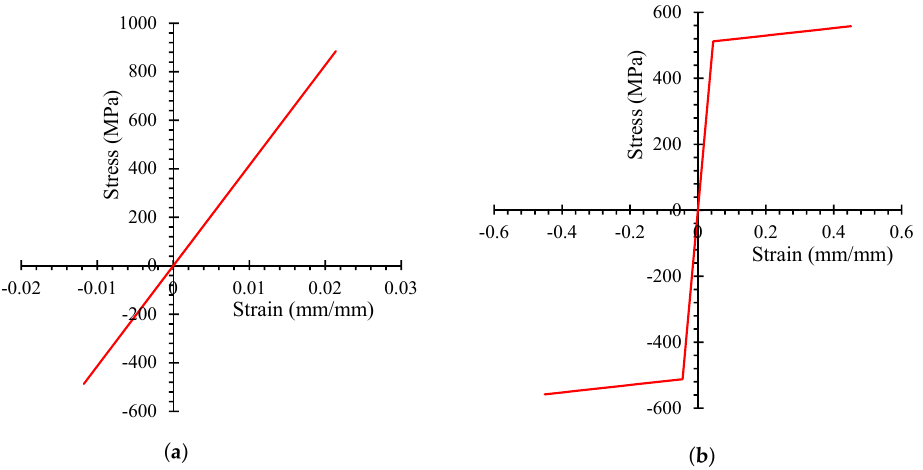
Figure 7. Reinforcement behaviors ( a ) linear elastic efficiency of glass-FRP rebars ( b ) elastic-plastic efficiency of steel